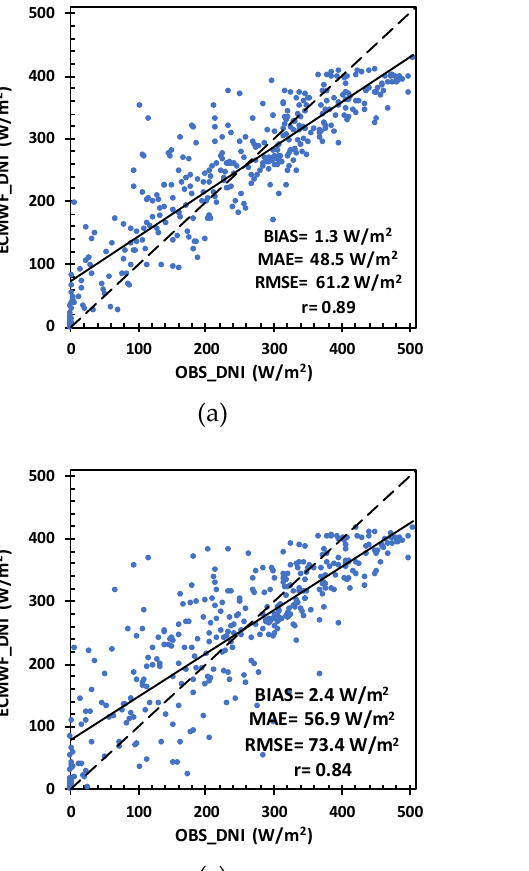
(d) Figure 7. Statistical indicators obtained from the comparison between measurements and predictions of daily mean DNI values. ( a ) MBE; ( b ) MAE; ( c ) RMSE; ( d ) correlation coefficient. ‐50‐30 ‐101030 50